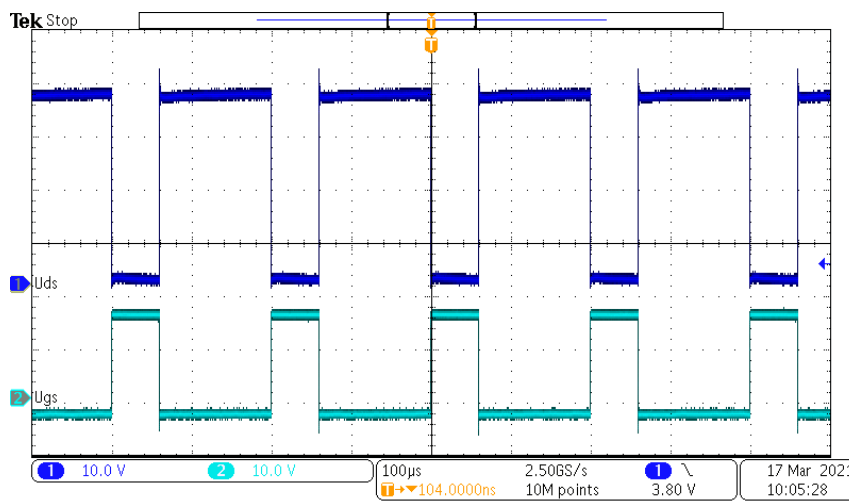
Figure 14. PWM signals (Blue, UDS voltage 10 V/div; Cyan, UGS voltage 10 V/div).